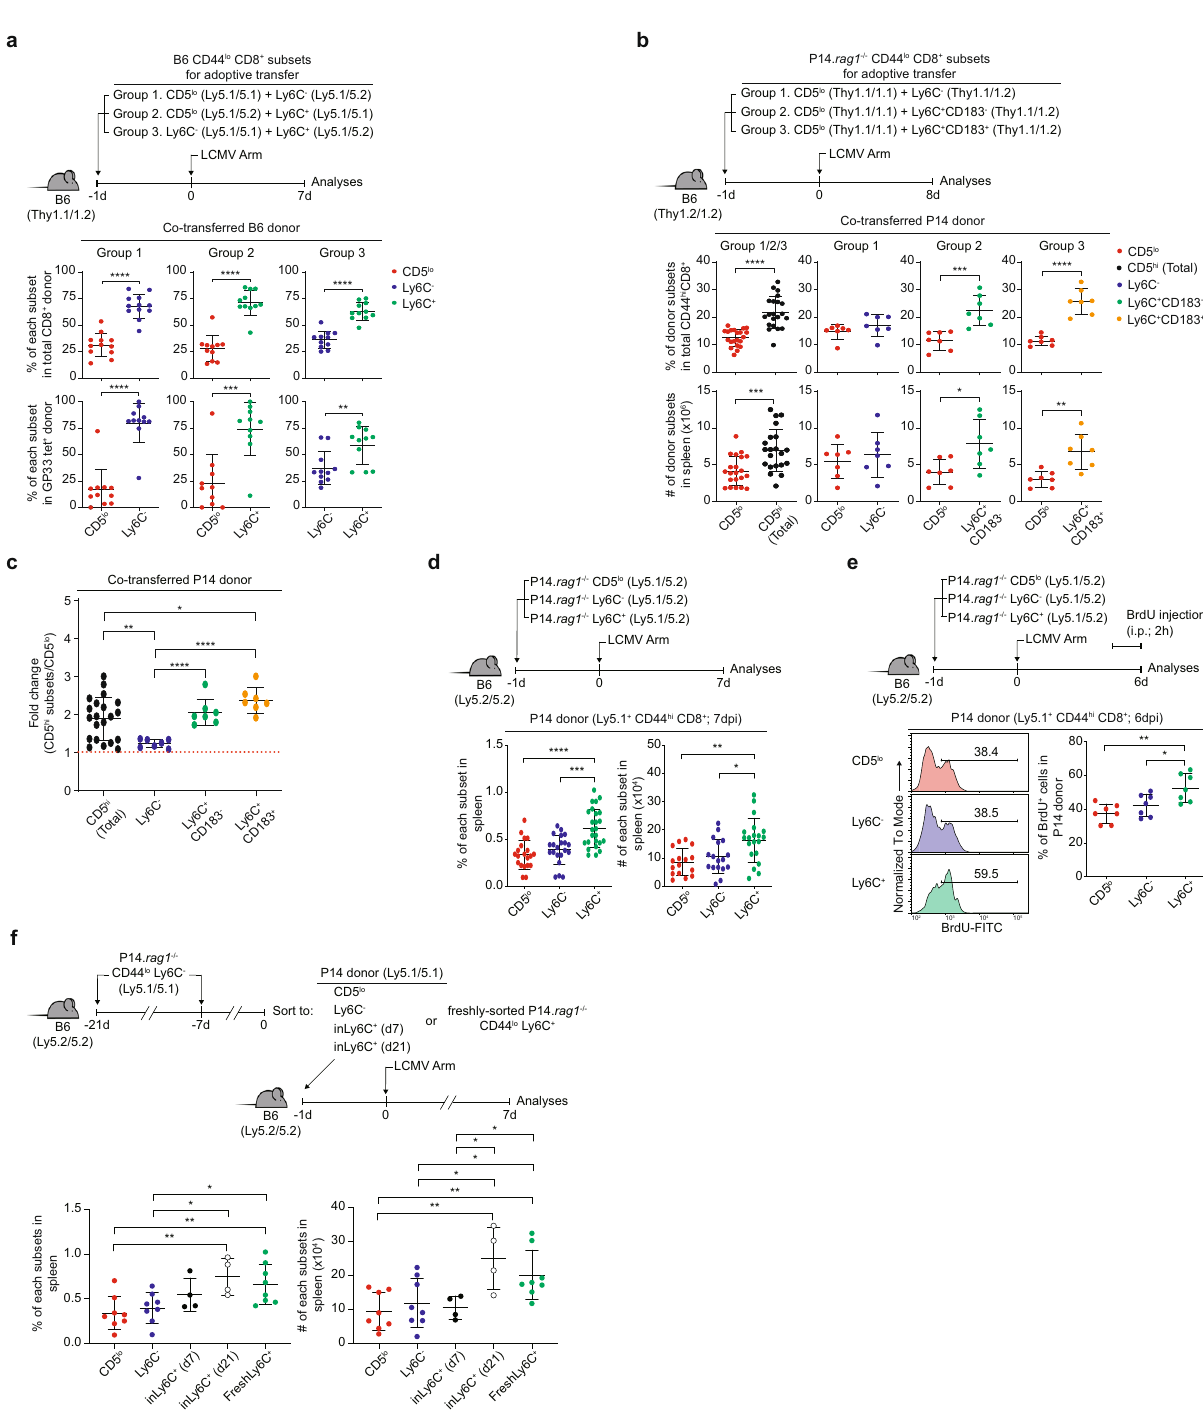
Fig. 5 Ly6C + cells exhibit greater expansion capacity upon LCMV infection. a Proportion of each donor subsets within CD44 hi CD8 + (upper) or CD44 hi CD8 + GP33- tetramer + B6 donor cells (lower) ( n = 12 mice for Group1, n = 11 mice for Group2 and Group3). b Percentage and donor recovery of co- transferred P14 subsets ( n = 21 mice for Group 1/2/3, n = 7 mice for Group1, Group2, and Group3). c Donor recovery of P14 CD5 hi subsets relative to P14 CD5 lo cells ( n = 21 mice for CD5 hi (Total), n = 7 mice for Ly6C − , Ly6C + CD183 − , and Ly6C + CD183 + ). d Percentage and donor recovery of individually transferred P14 subsets ( n = 20 mice for CD5 lo , n = 21 mice for Ly6C − , n = 25 mice for Ly6C + ). e Percentage of P14 CD44 hi CD8 + BrdU + donor cells ( n = 7 mice for each group). f Percentage and donor recovery of P14 subsets previously parked in B6 hosts ( n = 8 mice for CD5 lo , n = 8 mice for Ly6C − , n =